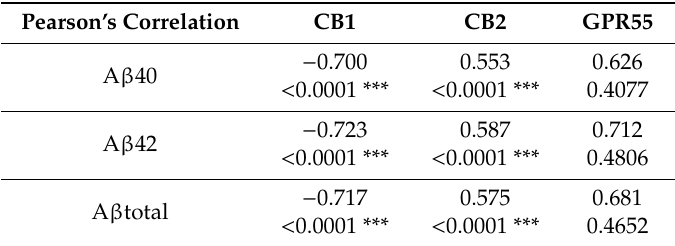
Table 3. Pearson’s correlation between endocannabinoids receptors (CB1, CB2, and GPR55) and the β -amyloid burden (A β 40, A β 42, and A β total) in the hippocampus of the 5xFAD transgenic mice. Pearson’s Correlation CB1 CB2 GPR55 − 0.700 A β 40